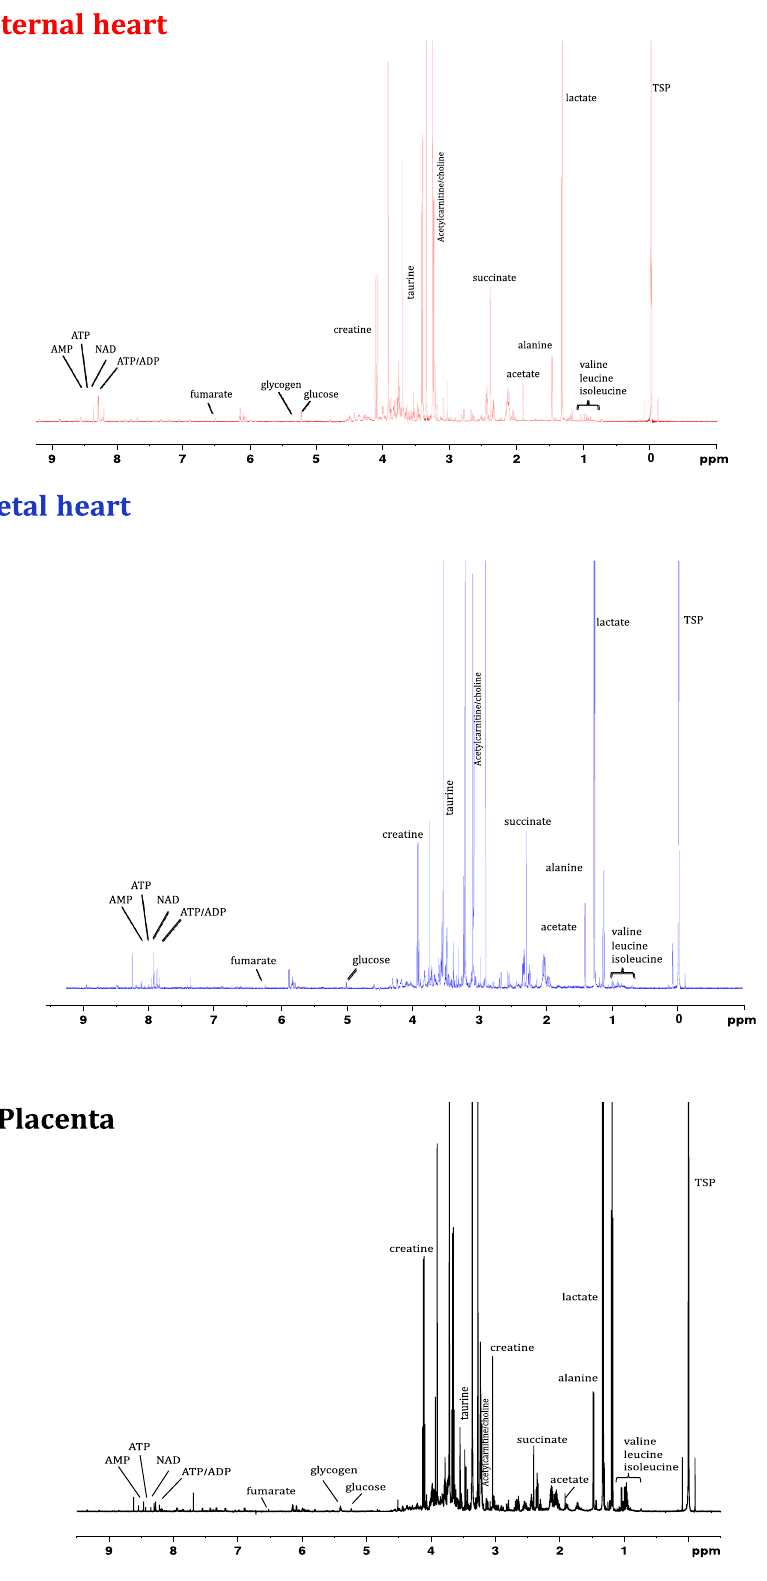
Figure 2. Representative 1 H NMR spectra from heart (maternal and fetal) and